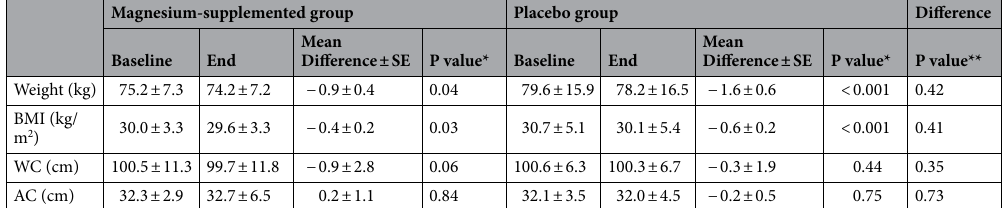
Table 2. Anthropometric indices of participants before and after intervention. BMI body mass index, WC waist circumference, AC arm circumference. *Resulted from paired t-test for comparing mean values of outcomes before and after intervention in each study group. **Resulted from ANCOVA for comparing two study groups based on mean values of outcomes after intervention and adjustment for baseline